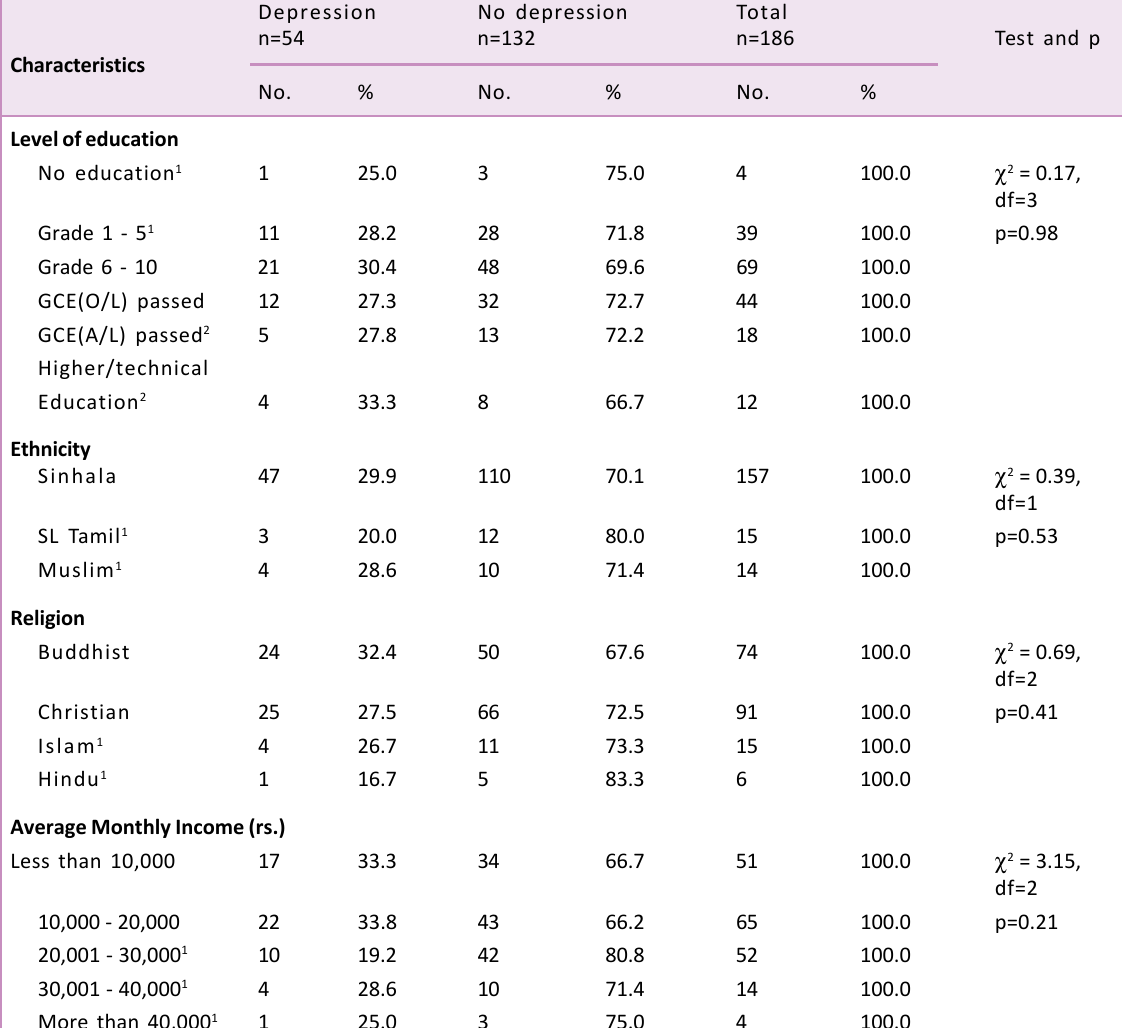
Table 3. Association between depressive disorder and social